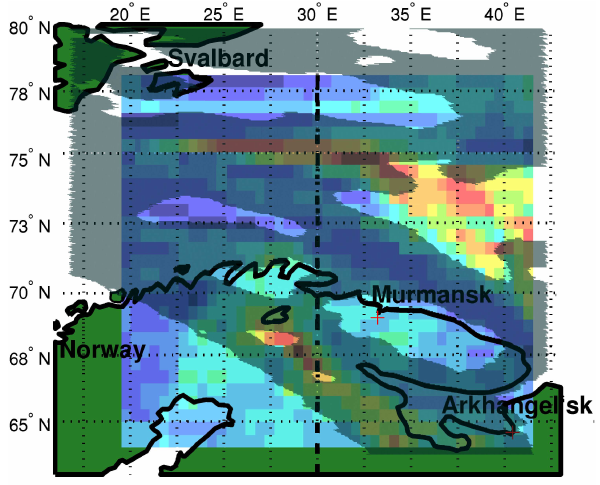
Fig. 2. Illustration of the horizontal and vertical co-location method, showing cloud with pressures from POLDER between 800hPa and 900hPa (gray shading) and average χ CO concentrations in ppbv for a layer between 1km to 2km altitude, colored shading. The dotted line is the location of the vertical transect shown in Fig. 3.